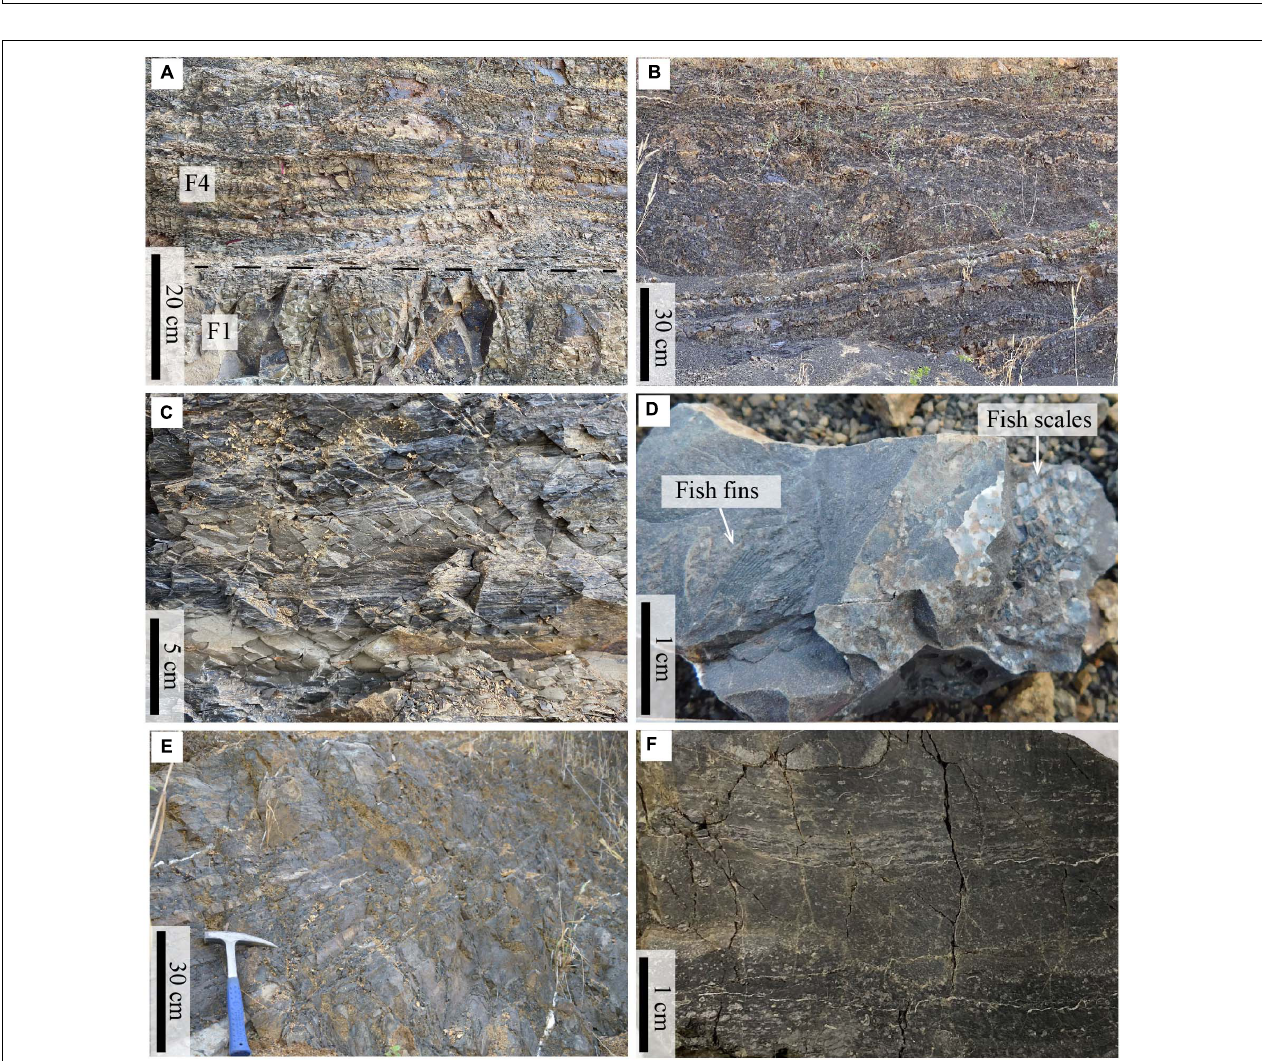
FIGURE 7 | (A) Interbedded siltstone and mudstone facies (F4) in the lower part of the section, overlying sandstone of F1. (B) Interbedded siltstone and mudstone facies in the middle part of the section showing mudstone beds are dominant. (C) Laminated mudstone intercalated with structureless siltstone. (D) Fossil of fish scales and fins found in F4 in the middle part of the section. (E) parallel beds of calcareous mudstone facies (F5). (F) Close-up textures of calcareous mudstone, showing laminations.